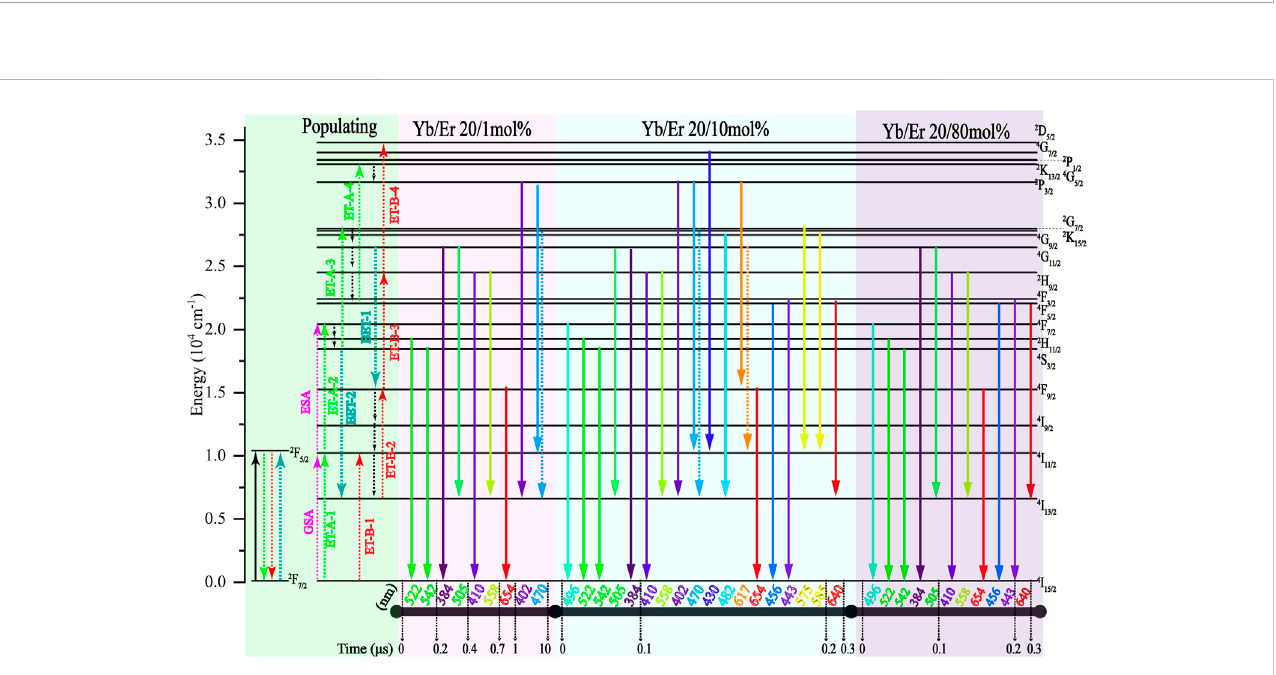
FIGURE 4 Transition mechanism of NaYF 4 :Yb 3+ /Er 3+ (20/x mol%) with different Er 3+ doping concentrations under 976 nm pulse excitation. The 976 nm ns-pulsed excitationstartsfromthe0moment.Greenpartisthepopulatingprocess.Redpartistheradiativetransitionprocessat x =1.Bluepartistheradiativetransition process at x = 10. Purple part is the radiative transition process at x =